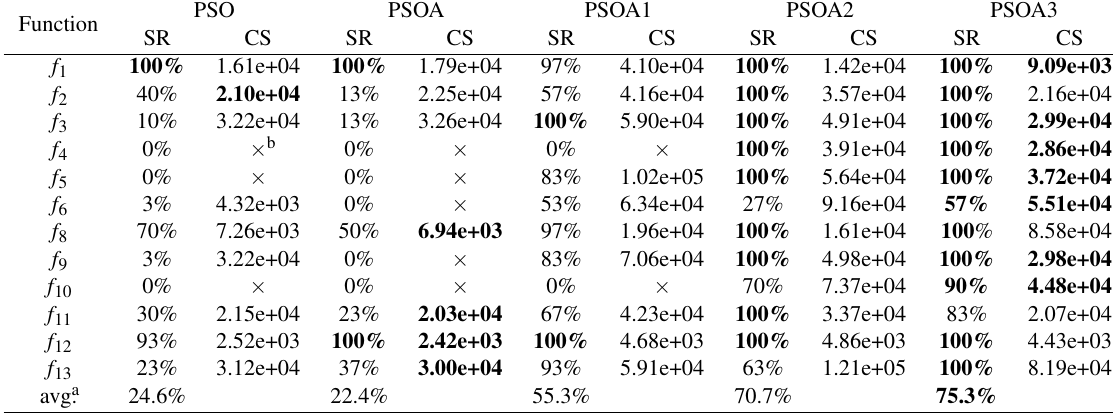
Table 6: Success rate and convergence speed in successful runs of the five PSOs